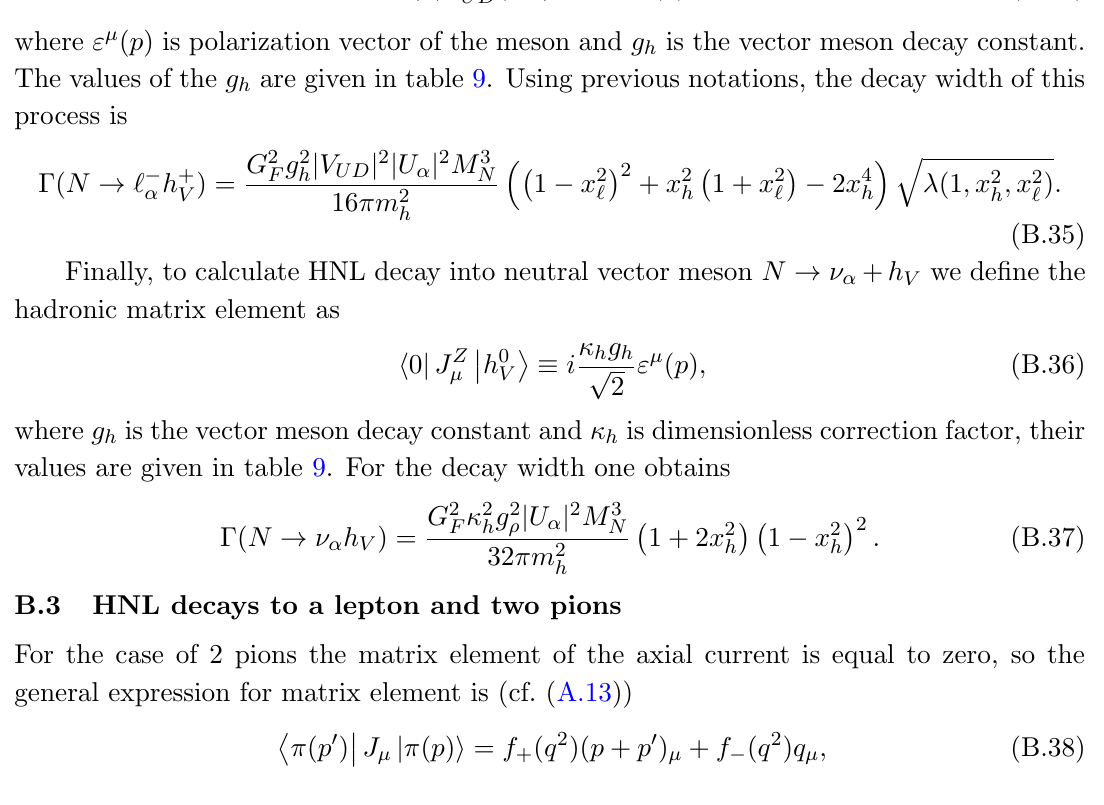
m (cid:26) . ’ current is given (cid:22)